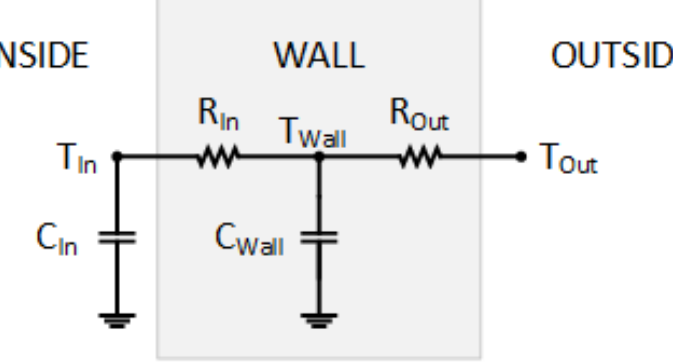
Figure 1. Simple RC representation of wall.